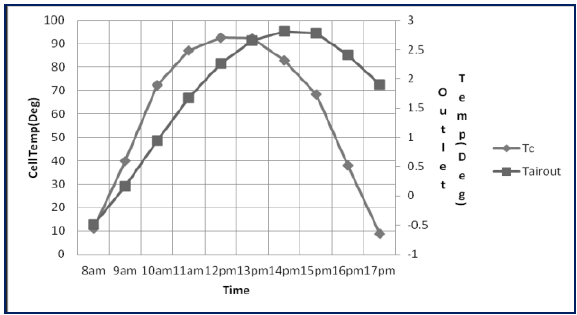
Figure 3. Comparative study of temperature between cell and duct